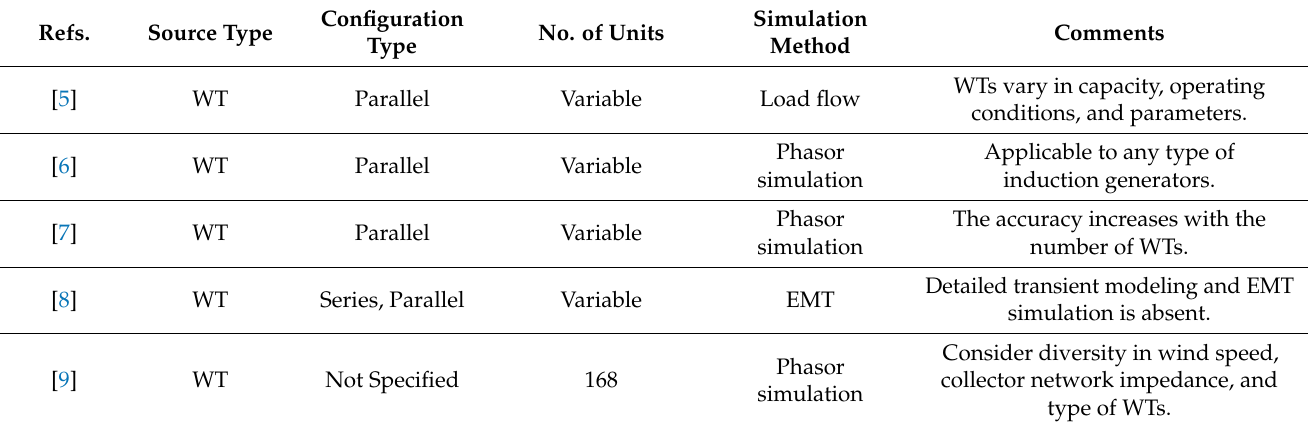
Table 1. Summary of IBR models presented in literature.